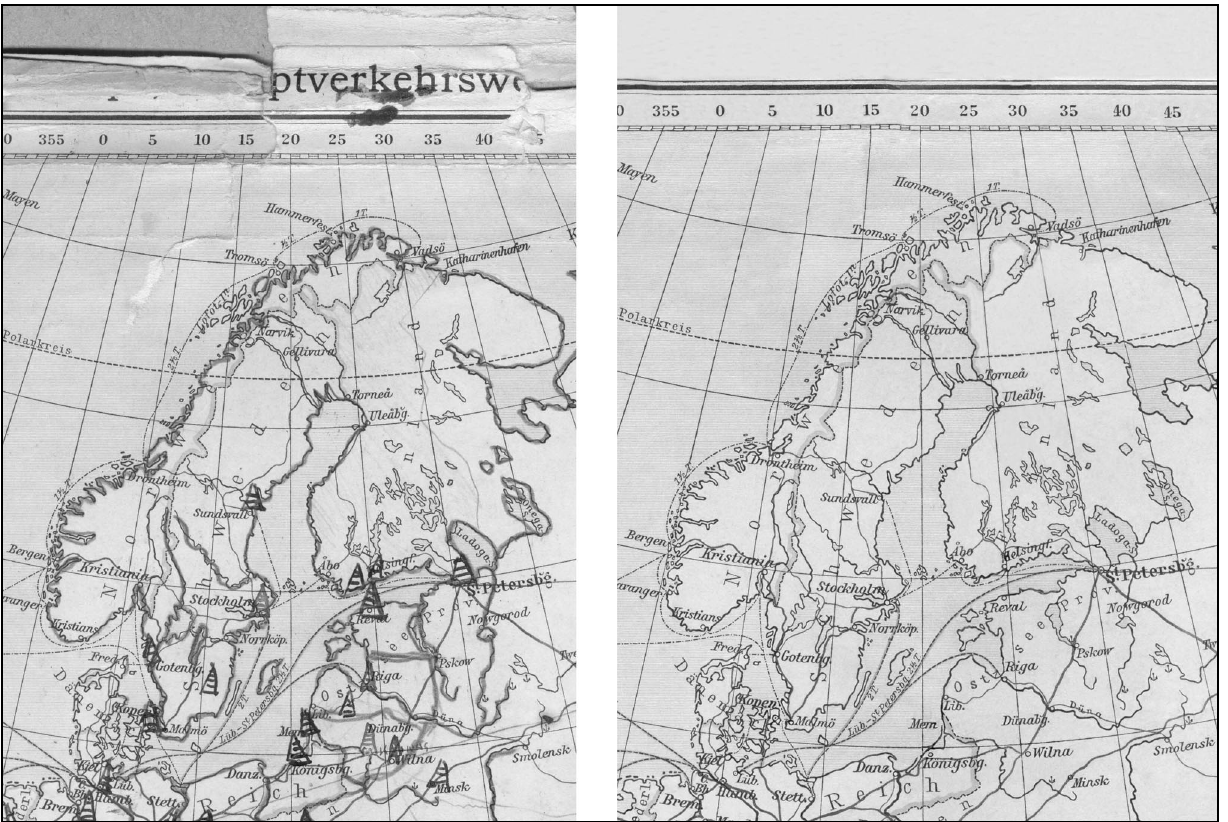
Fig 9. Part of old bad quality map: after scanning (left) and after restoration